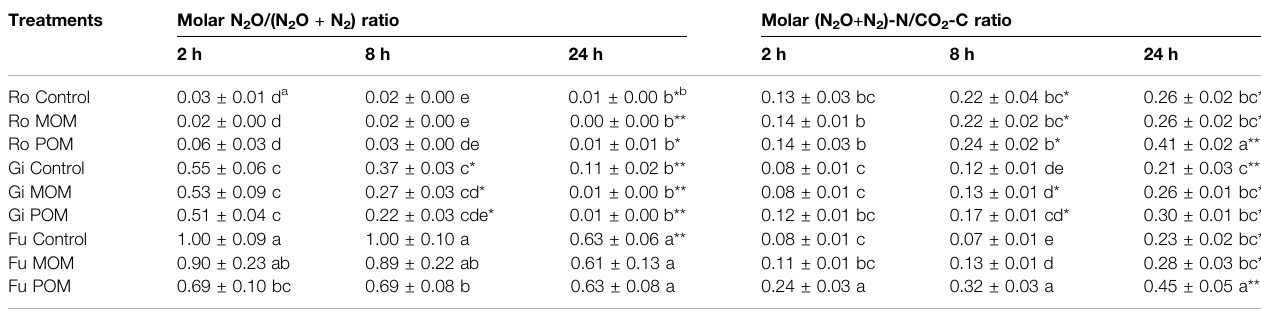
TABLE 5 | Molar N 2 O/(N 2 O + N 2 ) and (N 2 O + N 2 )-N/CO 2 -C ratios after 2, 8, and 24 h of anoxic incubation at 20 ° C of soils from Rotthalmünster – Ro, Giessen – Gi, and Fuhrberg – Fu without (control) and with addition of soil-derived particulate or mineral-associated organic matter (POM, MOM). Treatments